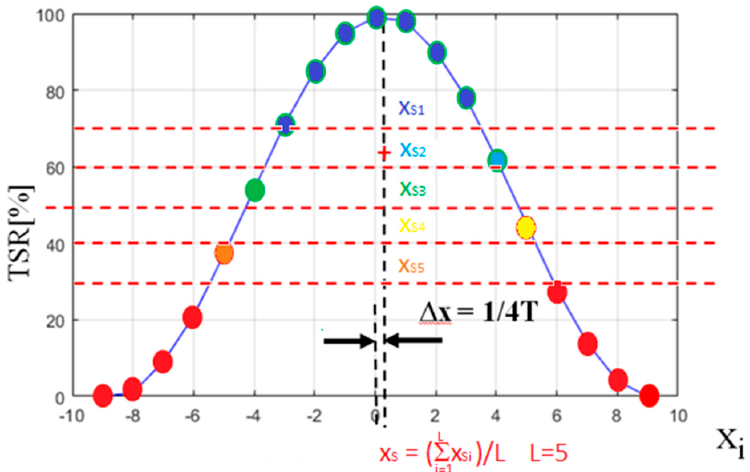
Figure 8. Illustration of the basic concept of calculation of the x s coordinate of the peak of a pulse using SDPA-M algorithm.